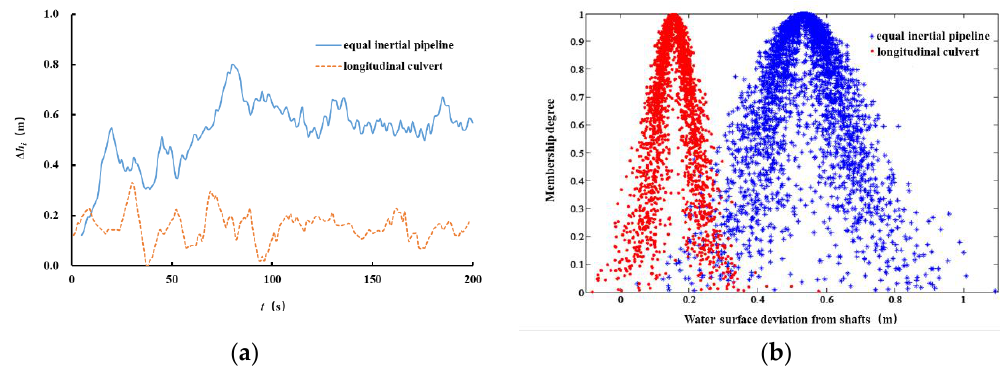
Figure 17. The change process of water surface deviation from the shafts in the filling–emptying system under the condition of a 150 m lifting height: ( a ) the diagram of the equal inertial pipeline and ( b ) the longitudinal culvert.